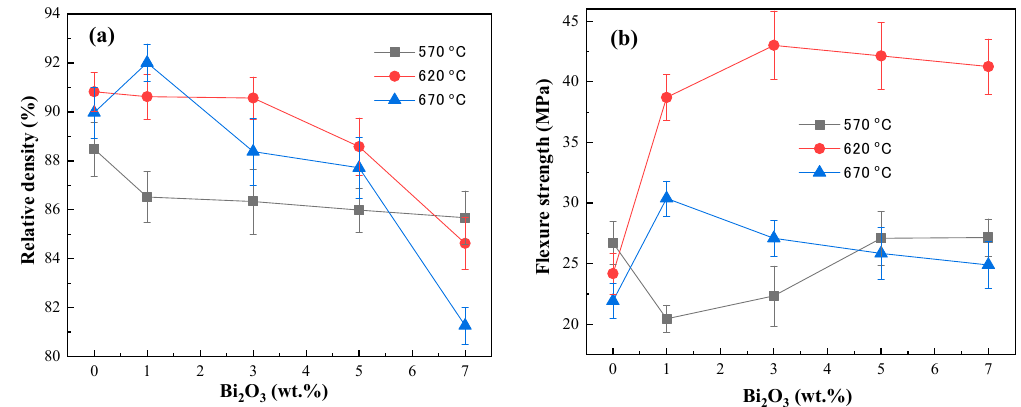
Figure 2. ( a ) Relative density and ( b ) flexure strength versus sintering temperature for PbO ceramics with different Bi 2 O 3 wt.%.